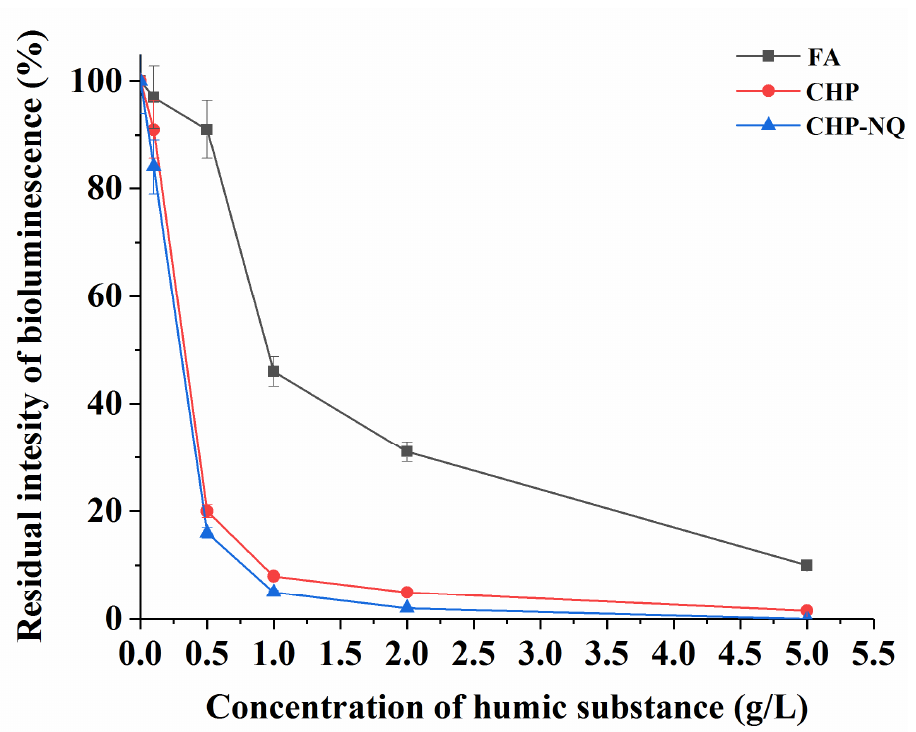
Figure 1. Decrease in the intensity of bioluminescence of firefly luciferase with an increase in the concentration of HS: FA—fulvic acids; CHP—potassium humate; CHP-NQ—potassium humate modified with naphthoquinone.